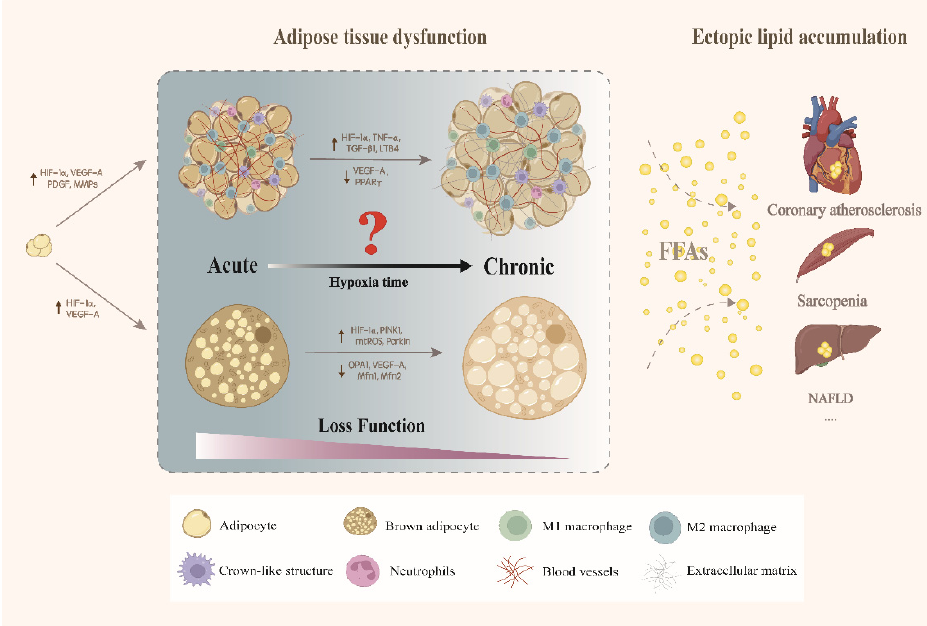
Figure 1. Adipose tissue adaptively remodels to cope with obesity (e.g., cell proliferation and expansion, increased energy metabolism). Angiogenesis is increased to counteract the acute endogenous hypoxic that accompanies adipocyte expansion. With the development of obesity, chronic endogenous hypoxic will induce inflammation, fibrosis of WAT and BAT “whitening”, leading to ectopic lipid accumulation in other organs. This may eventually give rise to metabolic diseases, such as coronary atherosclerosis, sarcopenia and NAFLD.